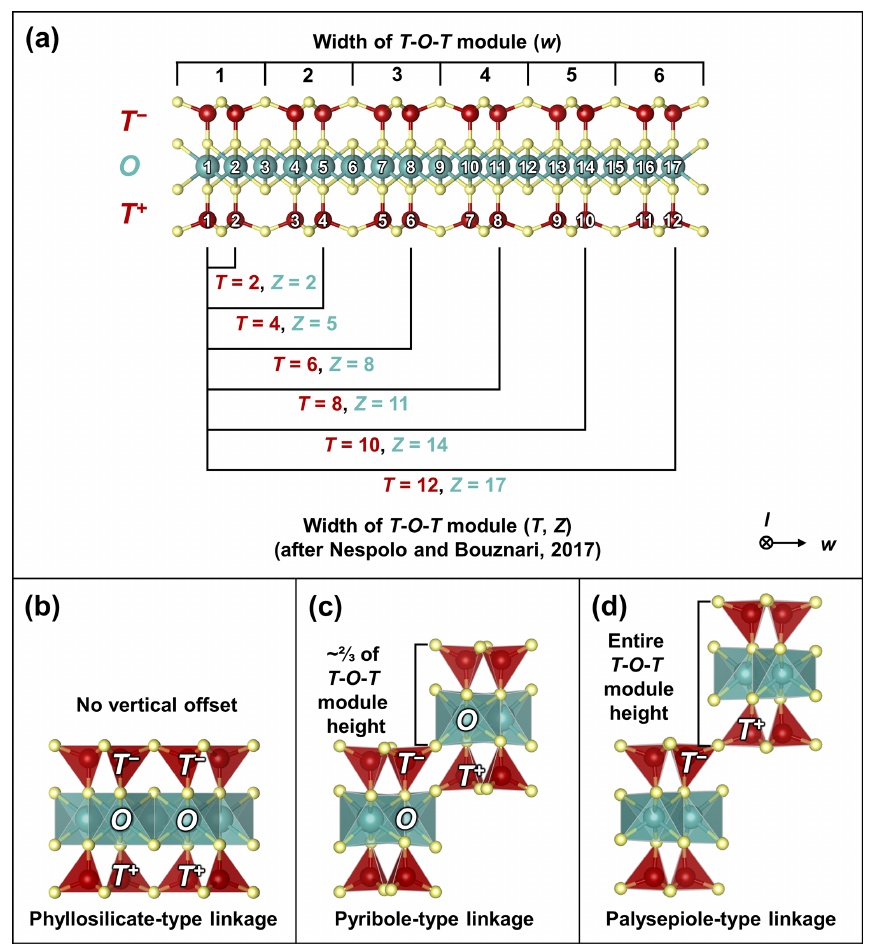
Figure 2. (a) Defining the widths of T - O - T modules. The first notation (top labels) describes the number of single-chain-width units ( w ) that exist within the modules (modified after Zoltai, 1981). The second notation (bottom labels) counts the number of sites ( T , Z ) that make up the T and O modules (after Nespolo and Bouznari, 2017; note that not all T and Z combinations are shown; see Sect. S1.2 for a discussion). (b–d) The three types of linkages for T - O - T modules: (b) phyllosilicate-type linkage, showing T + – T + , O – O , and T − – T − linkages (after Hendricks and Jefferson, 1939); (c) pyribole-type linkage, showing O – T + and T − – O linkages (after Cameron et al., 1973); (d) palysepiole-type linkage, showing T − – T + linkages (after Leung and McDonald, 2020). All crystal structures illustrated using VESTA (Momma and Izumi, 2011). The + and − notation indicates the orientation of the